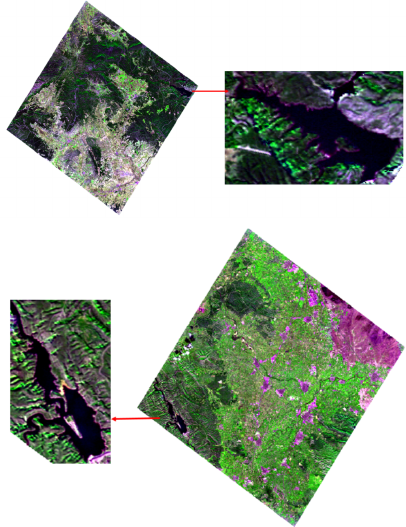
Figure 2. Benageber reservoir, (top) and Tous reservoir (bottom)